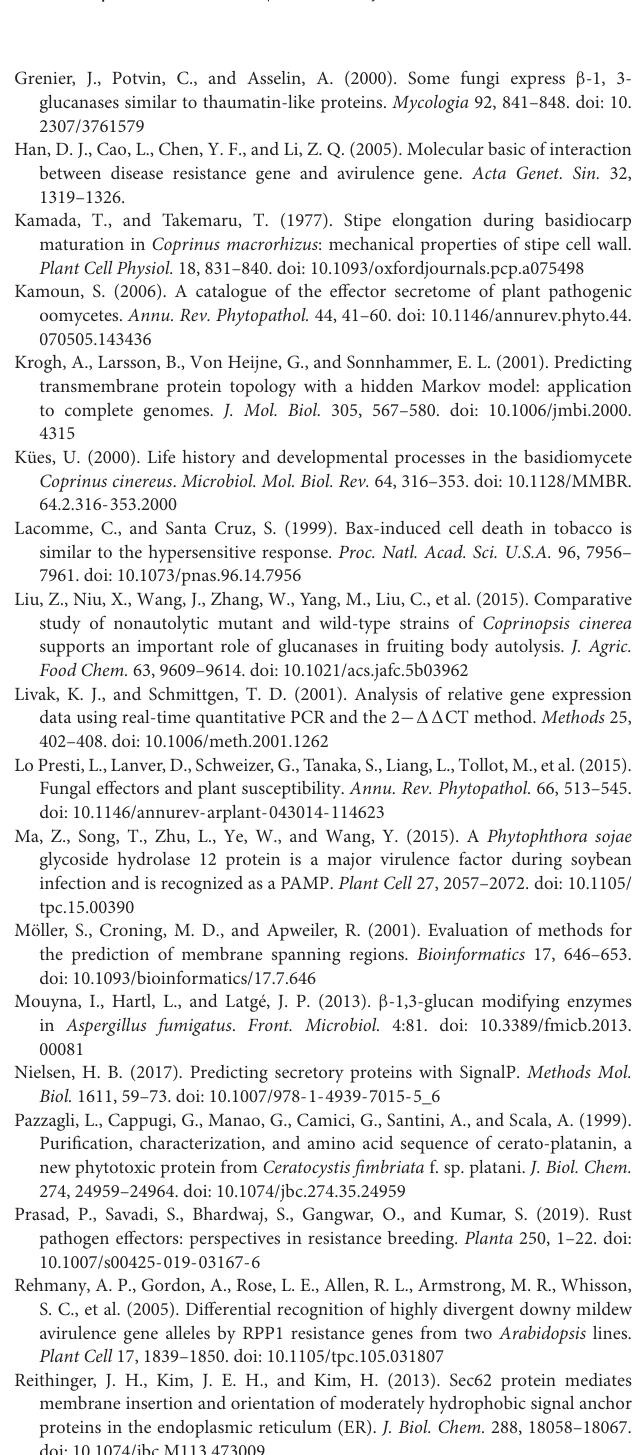
FIGURE S2 | Domains of other known functions of 635 candidate effector proteins. FIGURE S3 | Thirty candidate effector proteins that can inhibit the cell death triggered by BAX. 1–30 represents the candidate effector proteins Pt7277 ,